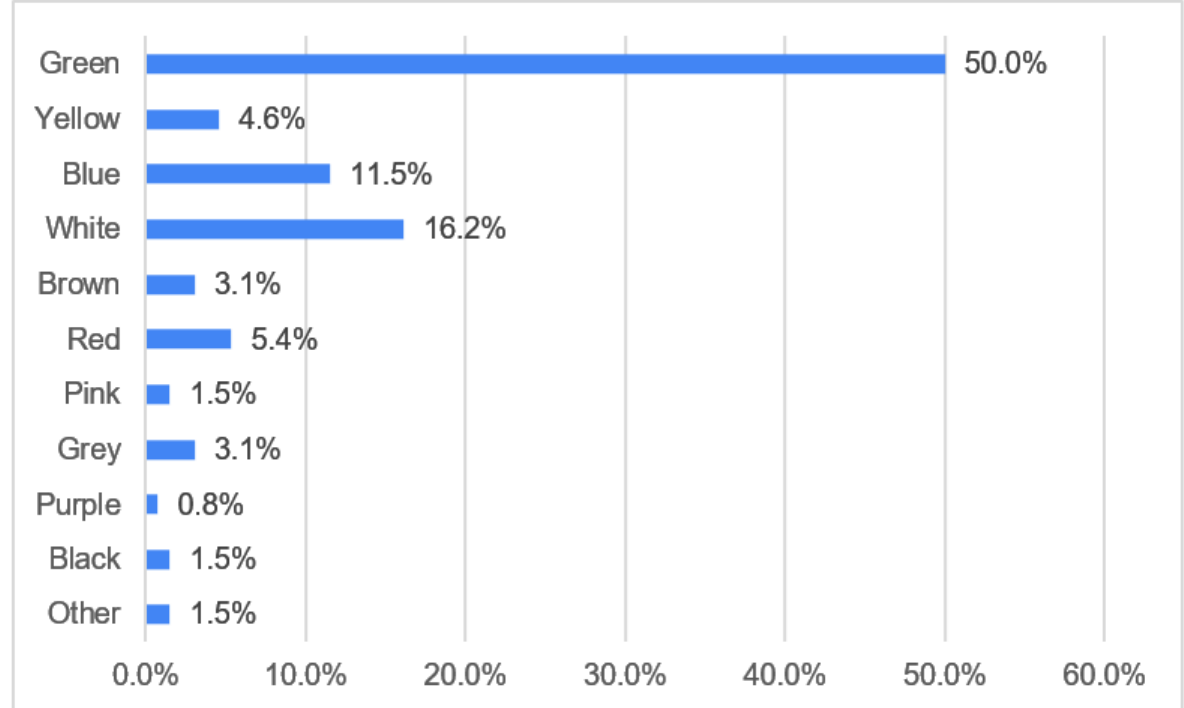
Figure 3. Packaging colour related to “healthy” .